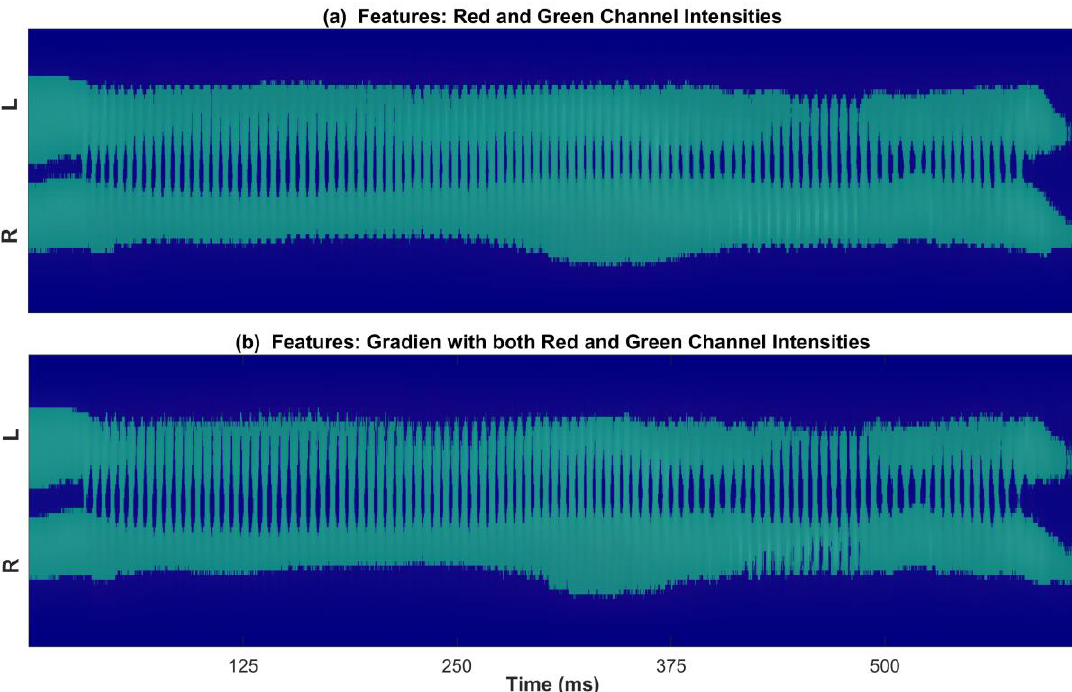
Figure 2. Scatter plots of the two clusters when applying the clustering method to the kymogram in Figure 1h between Frame 32,659 and 35,111: ( a ) using the green and red channel intensities as the features; and ( b ) using both green and red channel intensities along with the gradient as features.